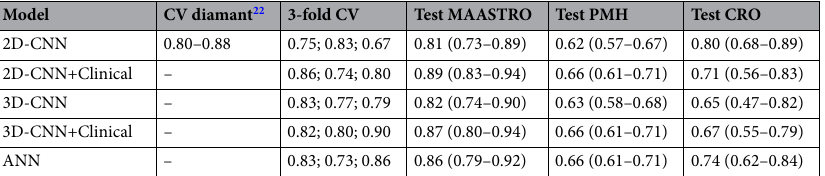
Table 1. Comparison of AUCs for CV in Diamant’s study 22 and CV and testing in our study. The numbers shown for the 3-fold CV are the AUCs obtained on the CV subsets. Numbers for the testing sets represent the median AUC and in brackets the 83% confidence intervals obtained via bootstrap re-sampling. Note that the AUCs in columns 2 and 3 can be compared directly as the CV was performed on the same cohort 23